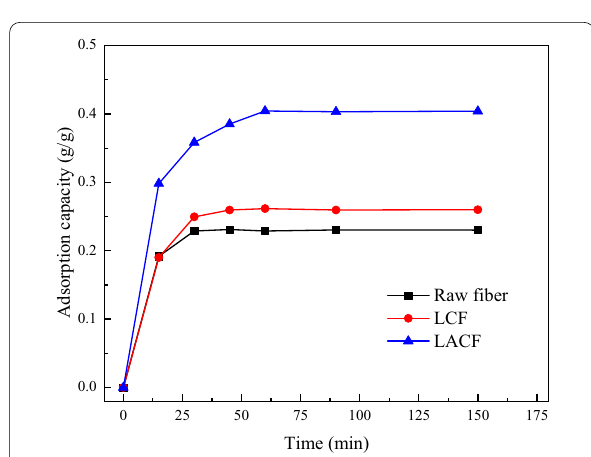
Fig. 15 Kinetics of water vapor adsorption to the raw fiber, LCF, and